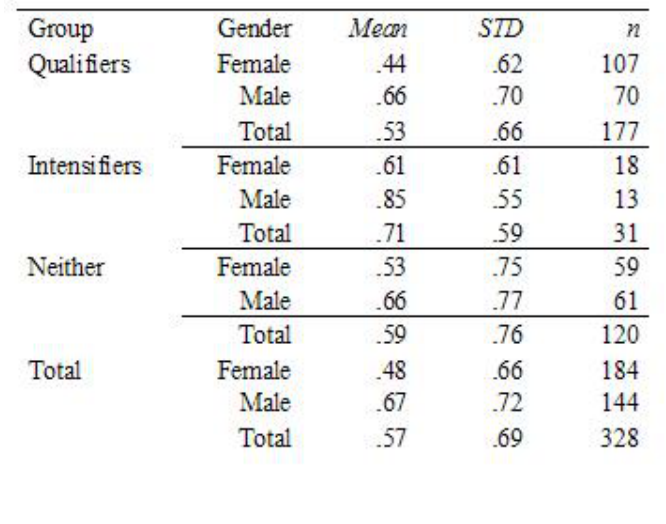
Note: Based on messages posted by 22 females and 10